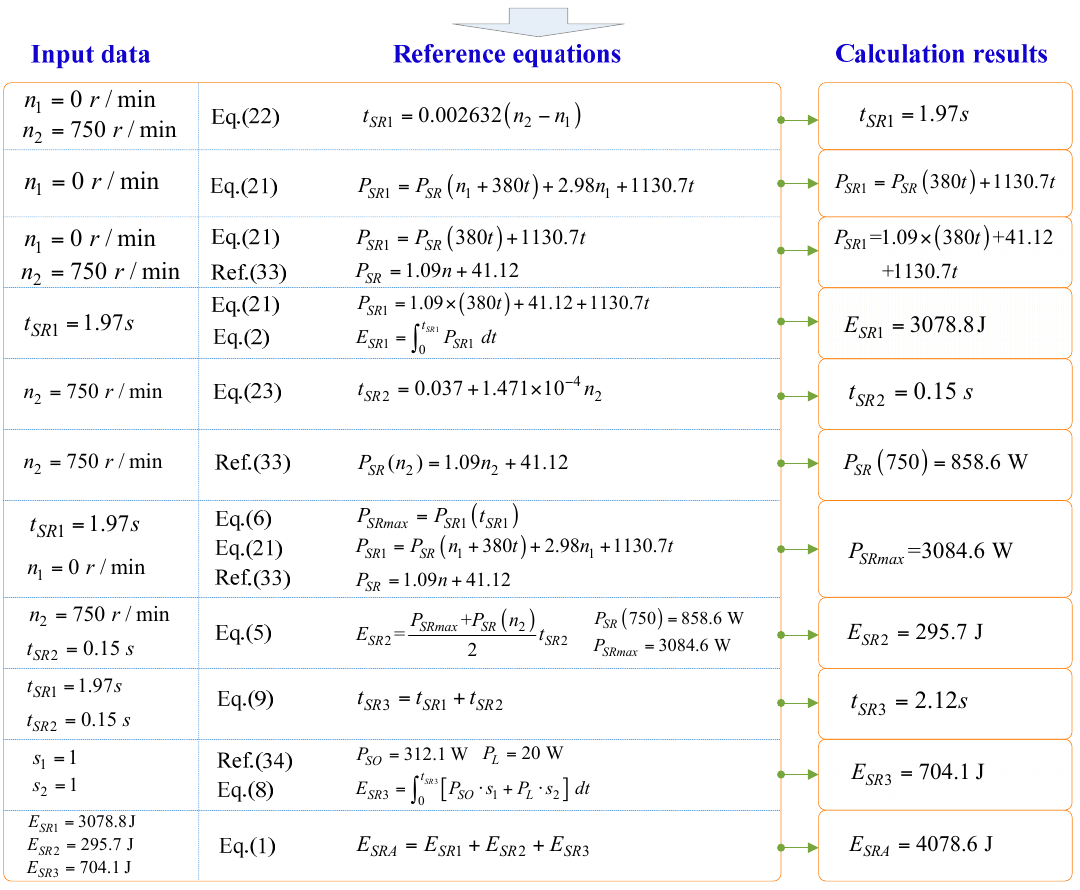
Figure 13. Calculation process of energy demand of spindle rotation (Ls → Hs)-[0 → 750 r/min].